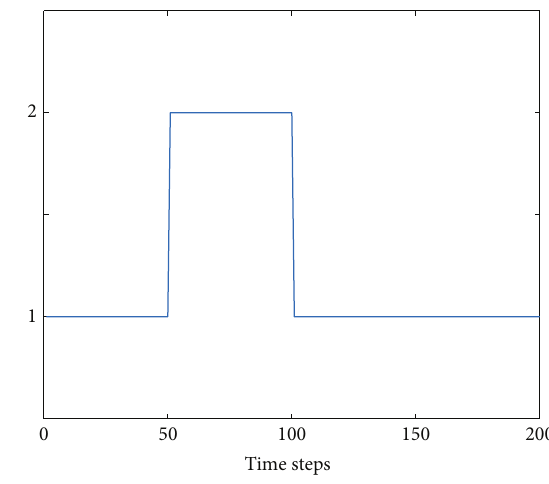
Figure 5: The switching sequence.